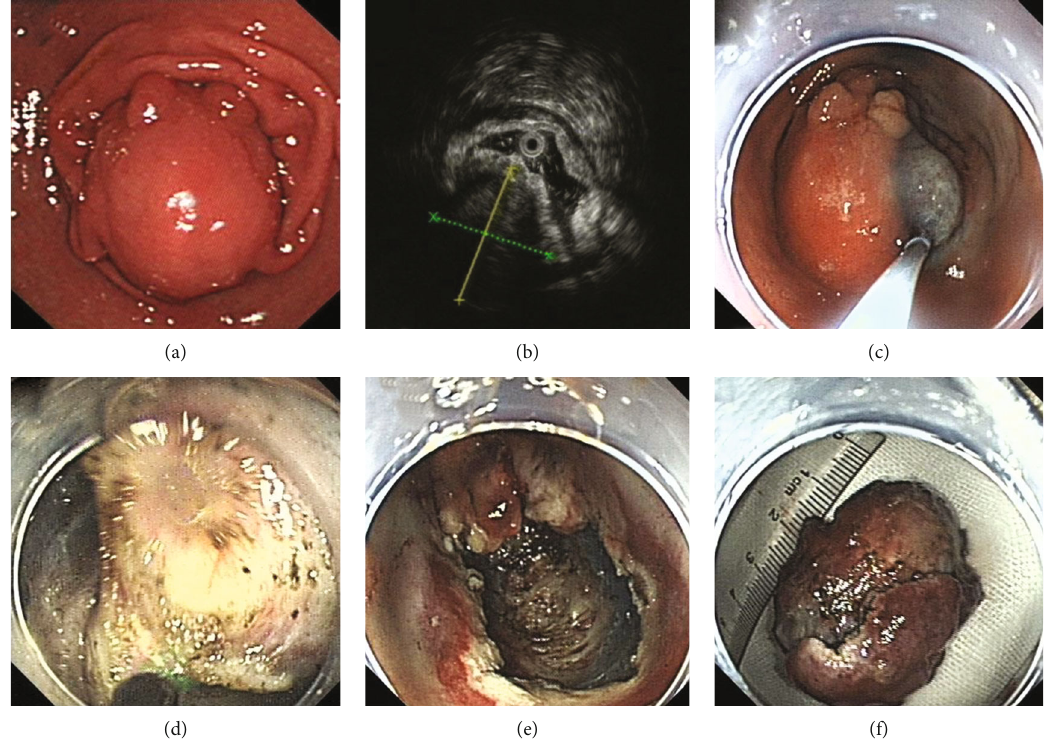
Figure 3: Endoscopic submucosal excavation treatment for a gastric GIST: (a) gastric GIST identi fi ed by endoscopy; (b) the same gastric GIST observed by endoscopic ultrasound; (c) marking the tumor; (d) resection of the tumor; (e) the wound after tumor removal; (f) the resected tumor. GIST: gastrointestinal stromal